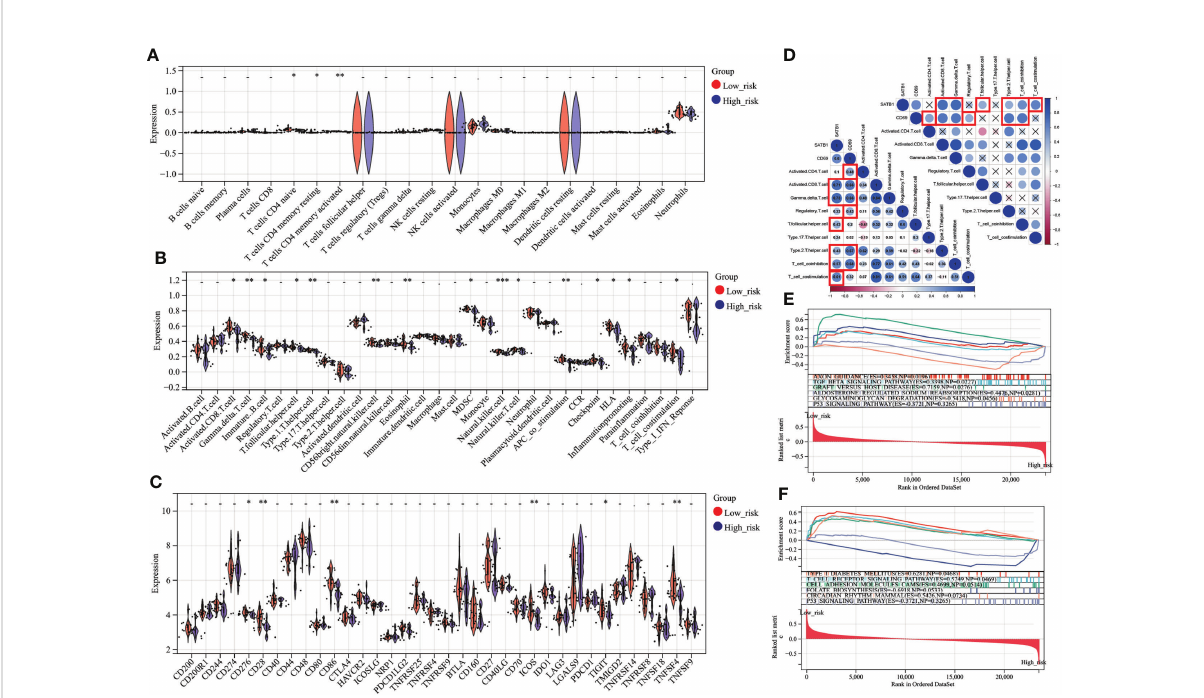
FIGURE 8 Immune analysis grouped by different risk scores (A) Comparison of 22 immune cells between different risk score groups. The vertical axis represents the proportion of immune cells. Cells with P < 0.05 were considered to be different between groups. (B) Comparison of immune cell and immune function scores between different risk score groups. The vertical axis is the rating. Cells with P < 0.05 were considered to be different between groups. (C) Comparison of immune checkpoint-related gene expression between different risk score groups. The vertical axis represents the gene expression level. Genes with P < 0.05 were considered to be different between groups. (D) Key genes, correlation analysis with T cell number and function. In the bottom left plot, blue represents a positive correlation, and red is a negative correlation. P > 0.05 is drawn as “ × ” in the upper right corner. Correlation coef fi cients > 0.4 and P < 0.05 are highlighted with red lines. P < 0.05:*, P < 0.01:**, P < 0.001:***. (E, F) . In the results of GSEA, different colors represent enriched pathways, and ES > 0 indicates that the genes of the low-risk group are enriched in this pathway, and ES < 0 means that the genes of the high-risk group are enriched in this pathway.